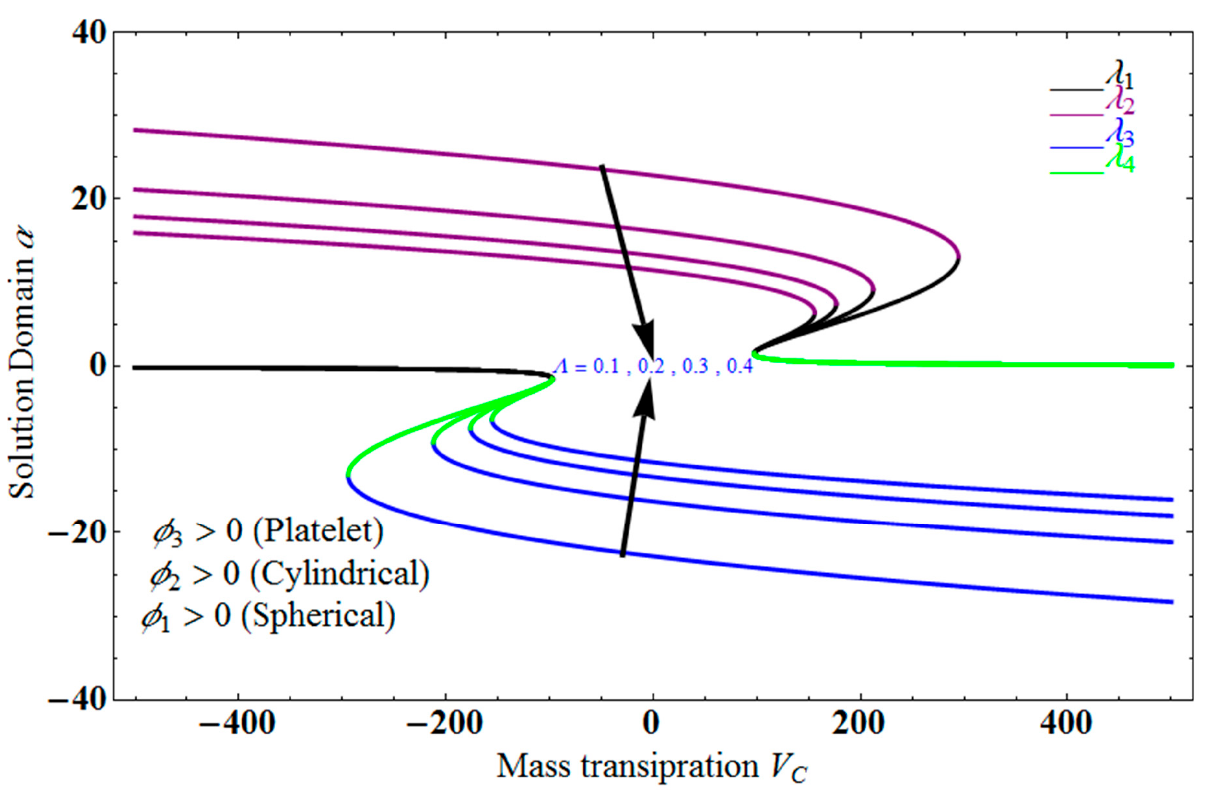
α verses mass transpiration